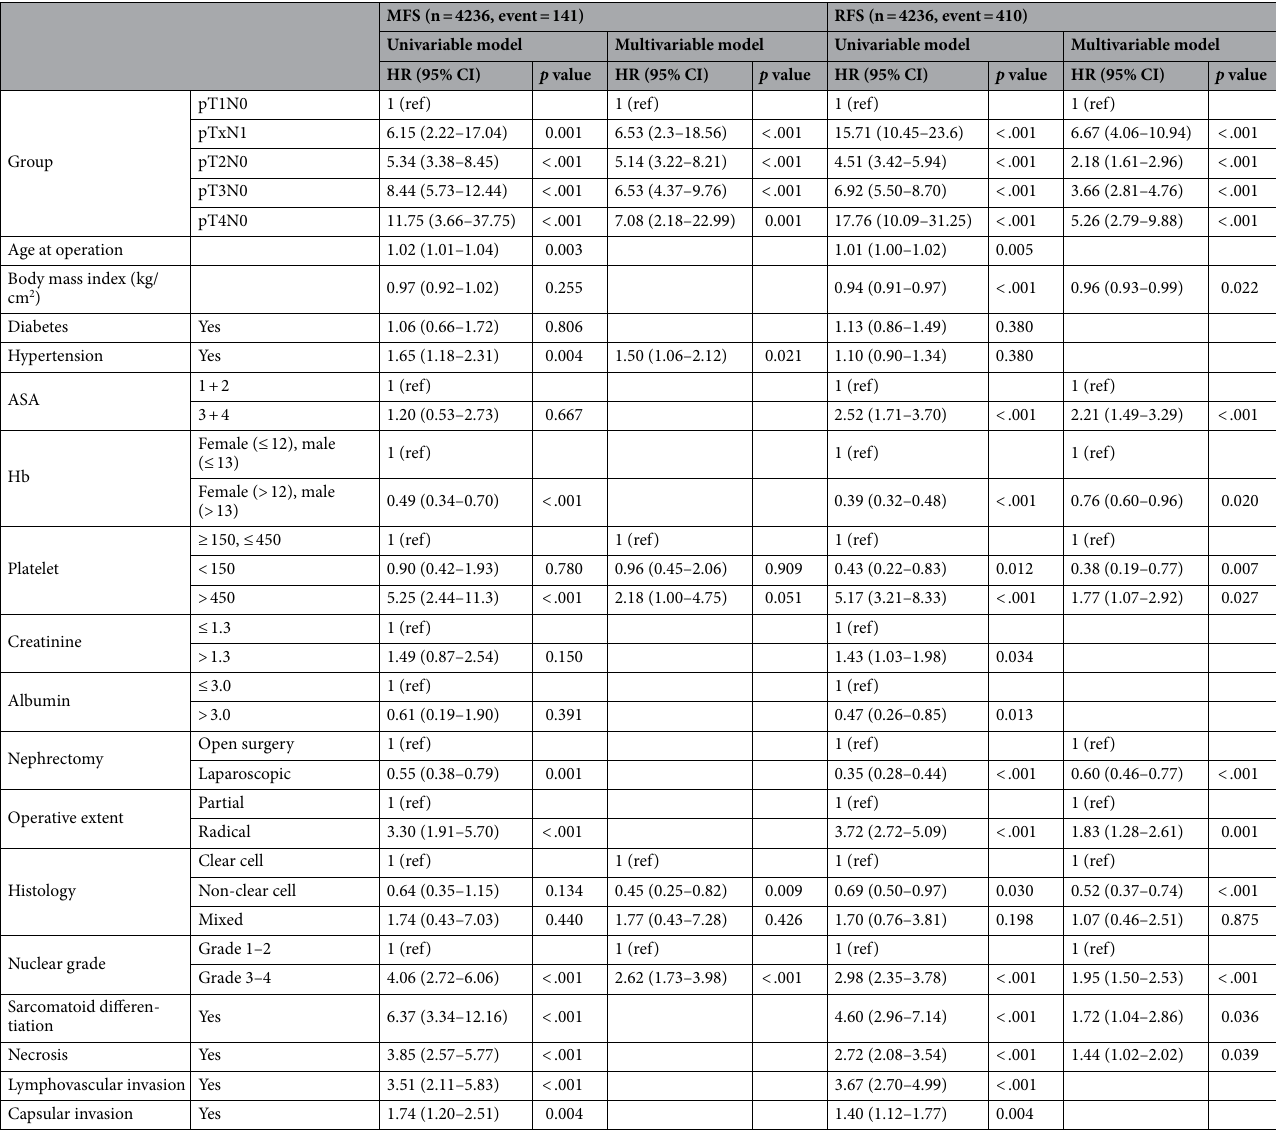
Table 2. Univariable and multivariable Cox proportional hazard model of metastasis-free survival (MFS) and recurrence-free survival (RFS) in five pTN